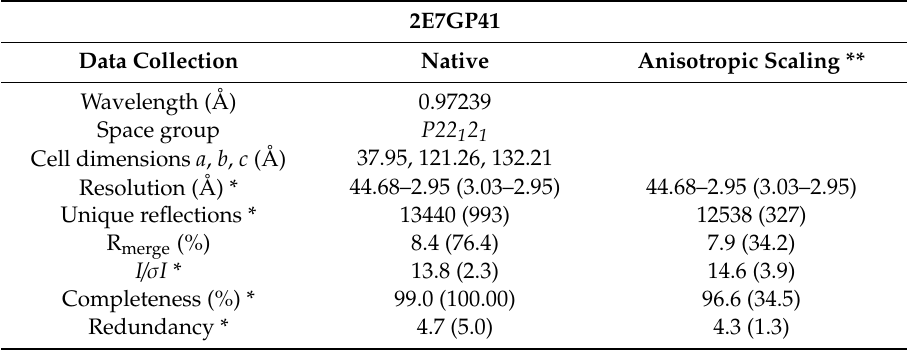
Figure 6. Mapping of the VHH epitopes onto the HIV-1 BG505 trimer (PDB ID 4TVP). ( A ) One monomer of the trimer is shown as a space filling model, carbohydrates are shown as sticks. The positions of the di ff erent VHH epitopes determined by crystallography and / or pepscan mapping are show in di ff erent colors. The distances between the epitopes were estimated and used to determine the linker length between VHH recognizing CD4bs (J3 and 3E3 and the epitopes recognized by the other VHH in the construction of a set of bi-specific VHH. The gp41 residues contacted by 2E7 are shown in Cyan, 1F10 in green. The 2E7 epitope located on gp41 HR1 is hidden in the trimer of the native Env gp140 conformation and not accessible for 2E7 binding. ( B ) Schematic of the domain organization of Env and location of the epitopes. Table 1. Data collection and refinement statistics of